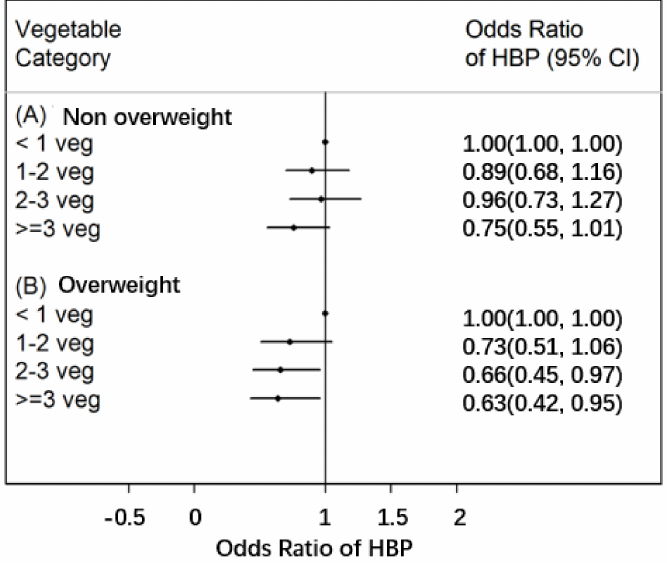
Figure 1. Associations between vegetable consumption and the risk of HBP stratified by BMI (non-overweight group and overweight group). HBP: high blood pressure. Values are adjusted for age, sex, province, BMI, physical activity, fruit consumption, smoking and alcohol intake. Overweight is defined as BMI ≥ the age- and sex-specific cut-off values (85th percentile) which includes individuals who are overweight and obese; non-overweight is defined as BMI < the age- and sex-specific cut-off values (85th percentile) which includes individuals who are normal weight and